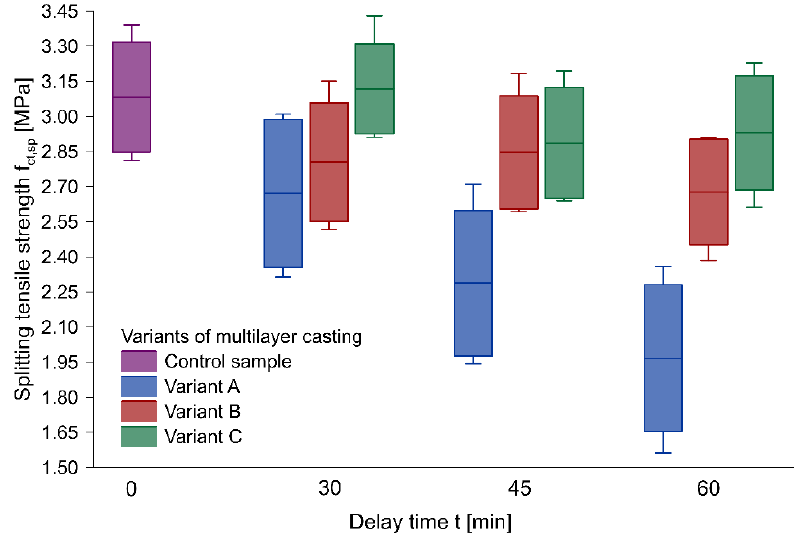
Figure 4. The relationship between the splitting tensile strength and delay time of successive layers.